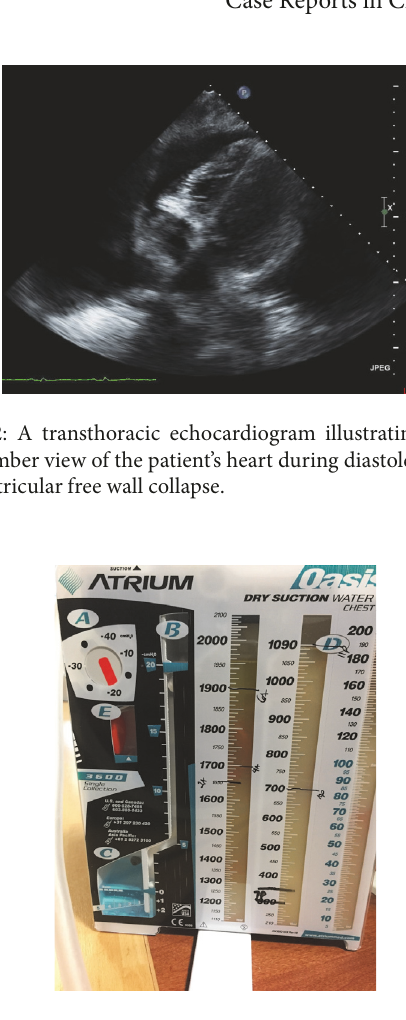
Figure 3: The patient’s left chest tube with 1950cc of fluid drainage. You can clearly see the pleural fluid transitioning from pure chylous to almost completely